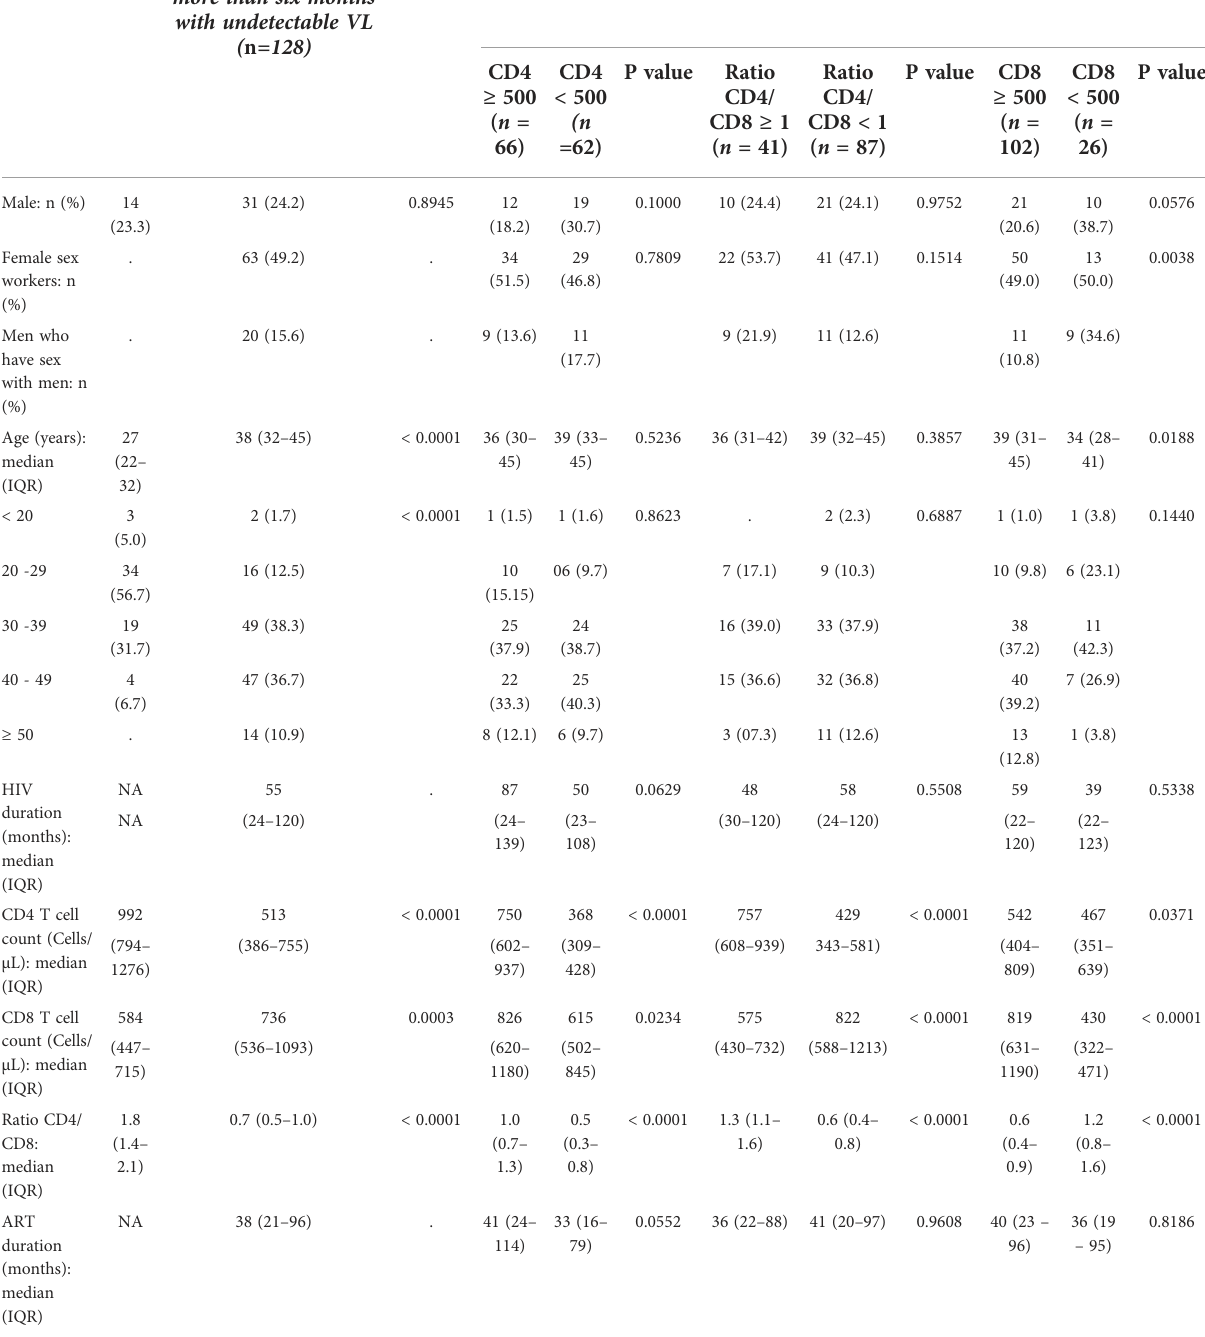
TABLE 1 Demographic and Clinical Characteristics of study participants. Control ( n =60) HIV+ ART-treated for more than six months with undetectable VL ( n